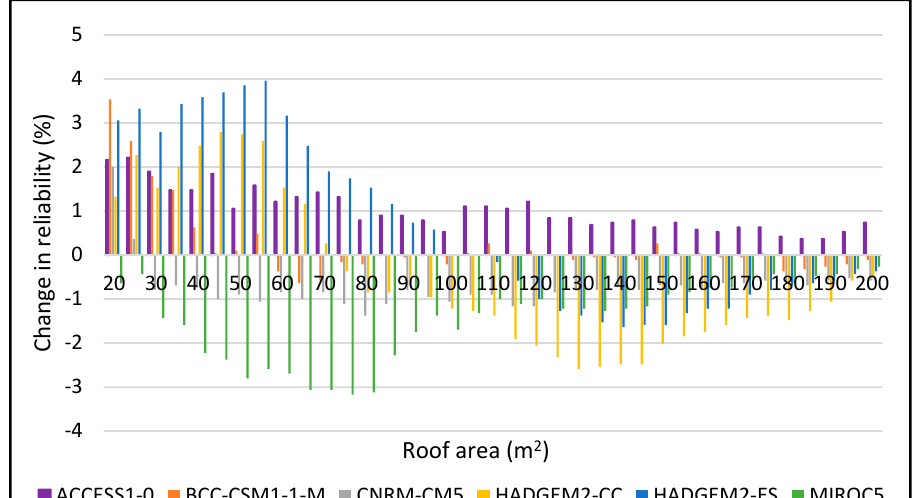
Figure 14. Change in reliability for DJF 2060–2090 period for 2 m 3 .